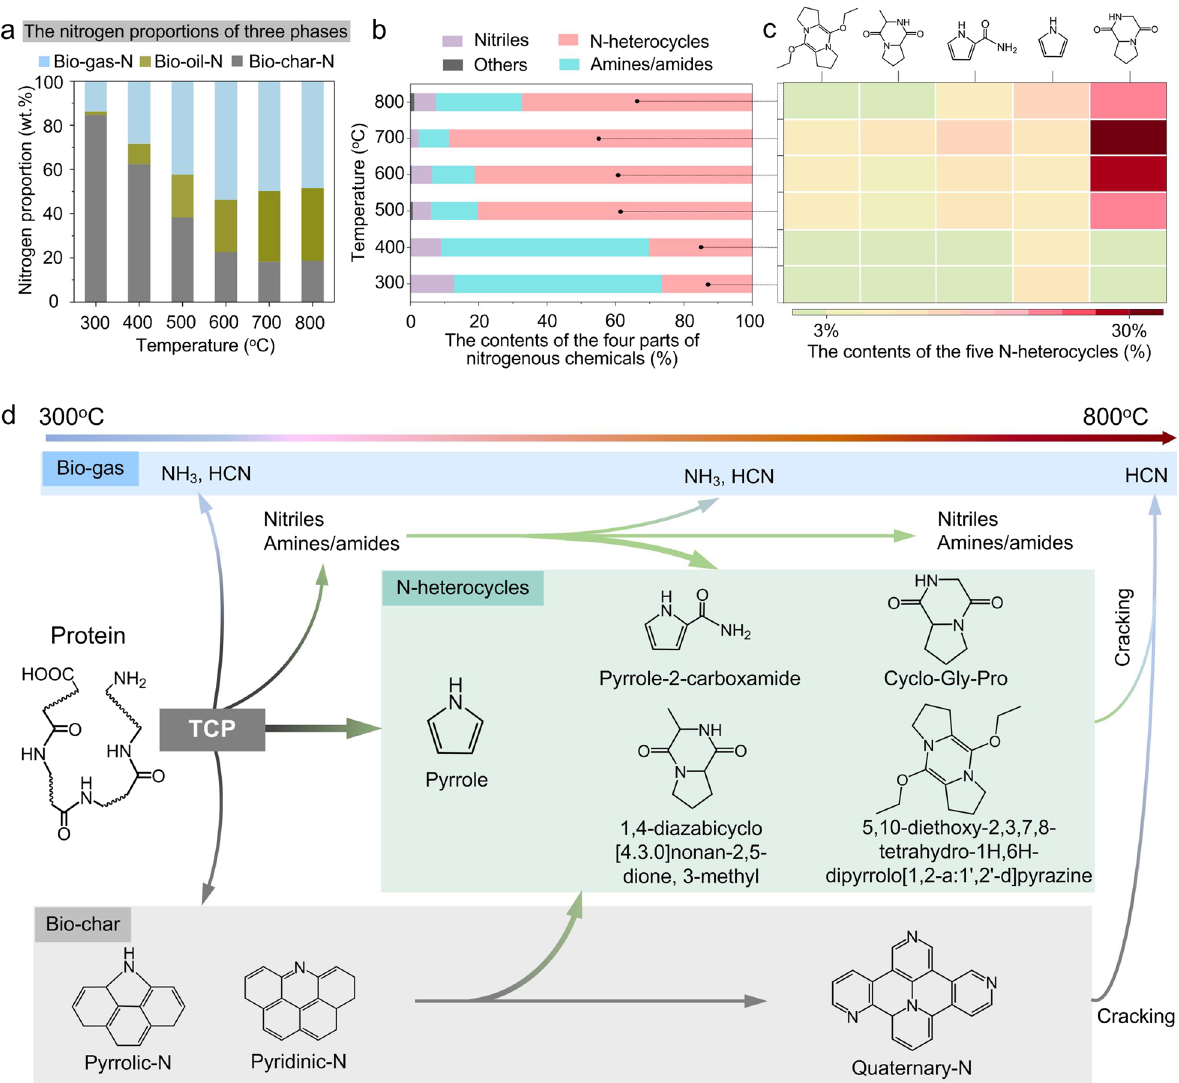
Fig. 4 Nitrogen transformation from bovine skin at different TCP temperatures. a Nitrogen proportions of three phases products (bio-gas-N, bio-oil-N, and bio-char-N) in total nitrogen. b The contents of the four parts of nitrogenous compounds (N-heterocycles, amines/amides, nitriles, and others) in all the nitrogenous compounds of bio-oil. c The contents of the five N-heterocycle products in all the nitrogenous compounds of bio-oil. d Proposed mechanism of nitrogen migration from bovine skin into